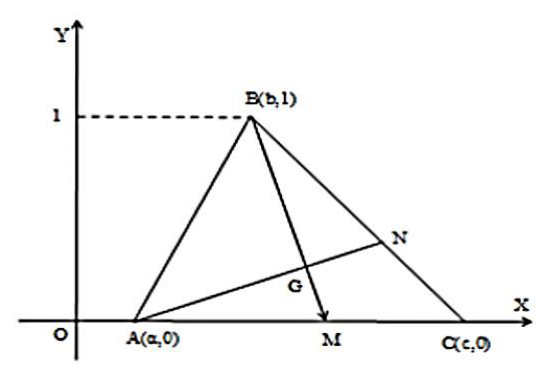
Fig. 1. Graph and COG of the TFN (a, b,